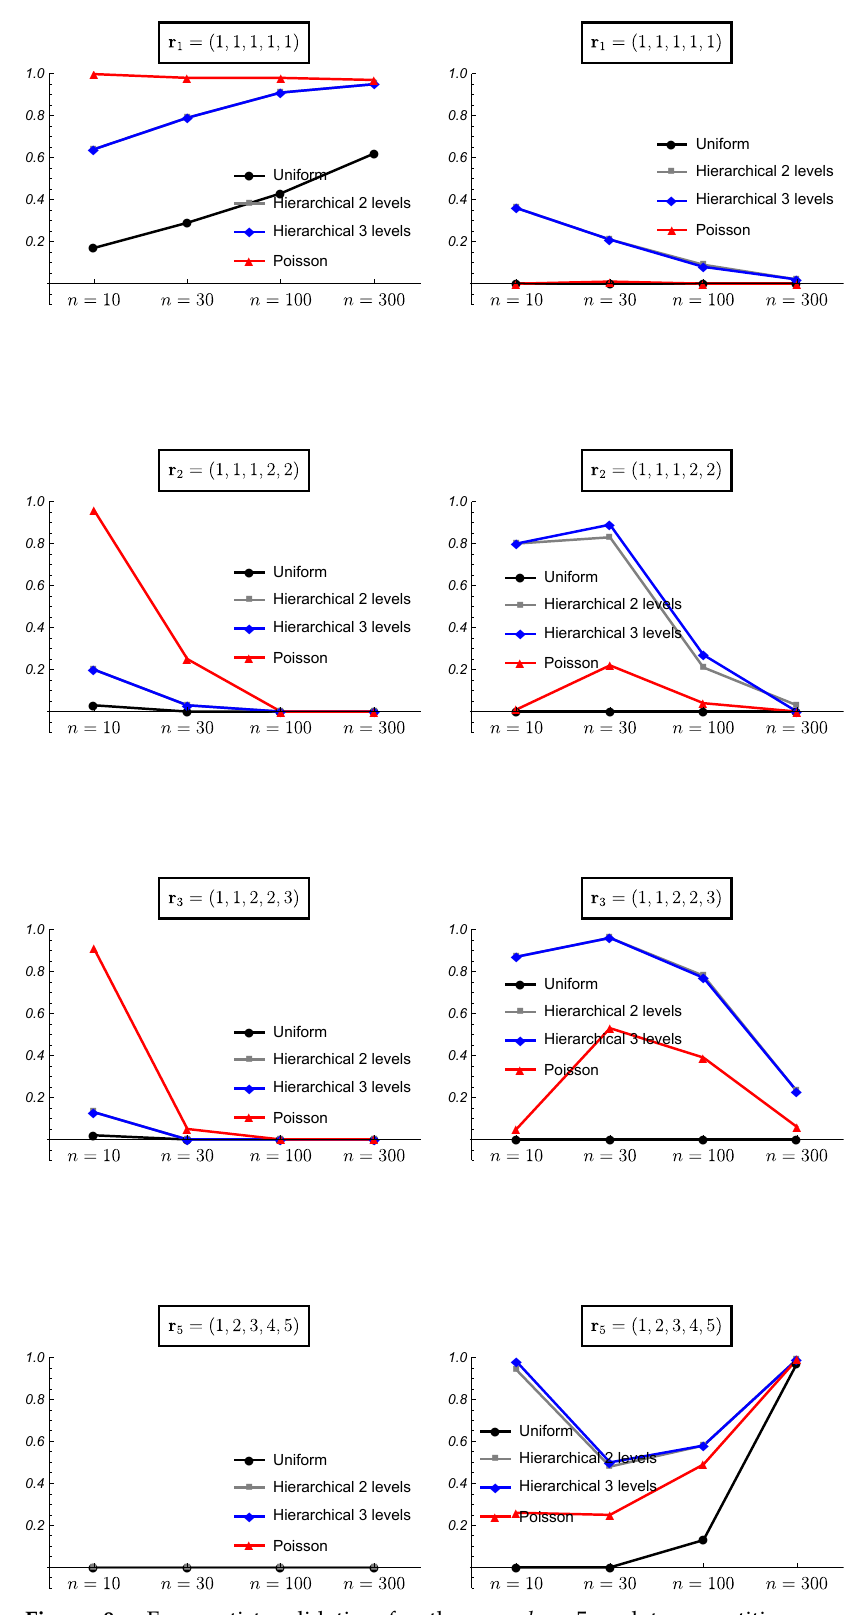
Figure 9. Frequentist validation for the case k = 5 and true partitions r 1 = ( 1,1,1,1,1 ) , r 2 = ( 1,1,1,2,2 ) , r 3 = ( 1,1,2, 2,3 ) , and r 5 = ( 1,2,3,4, 5 ) . ( Left column ) proportion of times the ho- mogeneity case is found as the most probable. ( Right column ) proportion of times the heterogeneity case is found as the most